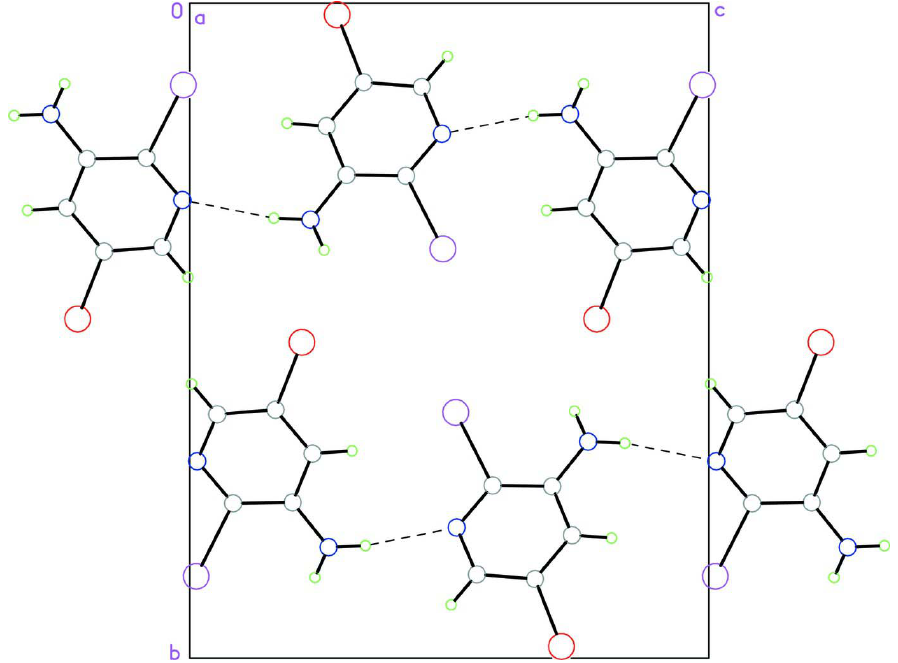
Figure 2 The crystal packing diagram viewed down the x